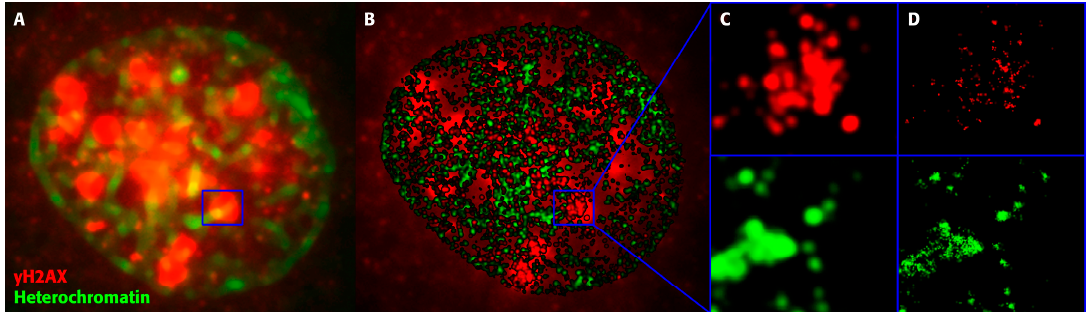
Figure 5. Image section of a cell nucleus of a breast cancer cell line (SKBr3) after staining of heterochromatin (green) and γ H2AX foci (red) by fluorescent specific antibodies. The cells were irradiated by 1 Gy photon-radiation and the images were acquired 60 minutes after irradiation during activated repair. ( A ) wide-field fluorescence image, scale bar: 2 μ m ; ( B ) localization microscopy image of the same image section, scale bar: 2 μ m; ( C ) enlarged inserts of A separated in the color channels red and green, image size 2 μ m × 2 μ m; ( D ) enlarged inserts of B separated in the color channels red and green, image size 2 μ m × 2 μ m.